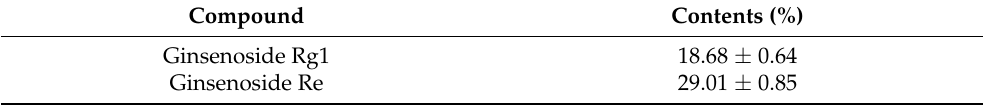
Table 1. Contents (%, mean values ± SDs, n = 3) of two compounds in PTS .